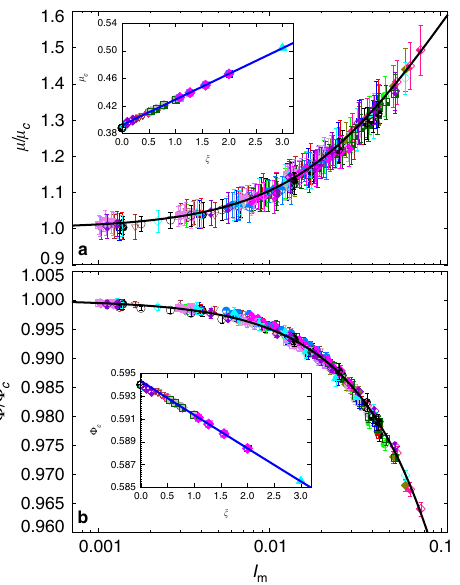
Fig. 3 Rescaled simulation data. Normalized apparent friction coef fi cient μ ∕ μ c ( a ) and normalized packing fraction ϕ ∕ ϕ c ( b ) as a function of the generalized inertial number I m de fi ned by Eq. (1) with α ≃ 0.062 and β ≃ 0.075. The error bars represent the standard deviation of the data over the steady-state fl ow. The symbols are the same as those in Fig. 2. The black- solid lines are the analytical expressions of Eqs. (6) and (7). The insets show the evolution of quasistatic values μ c and Φ c of the apparent friction coef fi cient and packing fraction, respectively, with the cohesion index ξ , and their linear fi ts (blue-solid